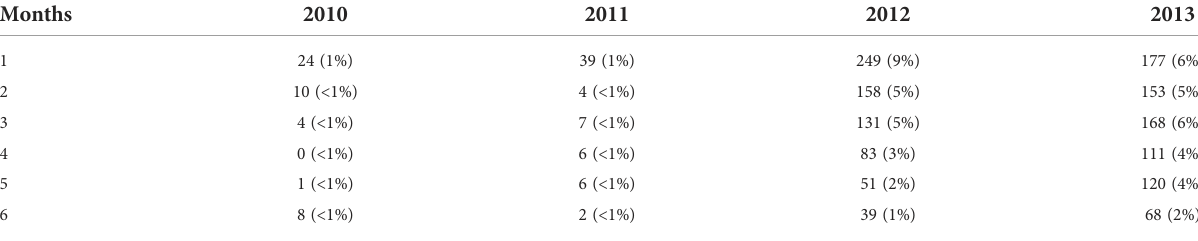
TABLE 1 Number of ROMS virtual particles within 3 km of their deployment